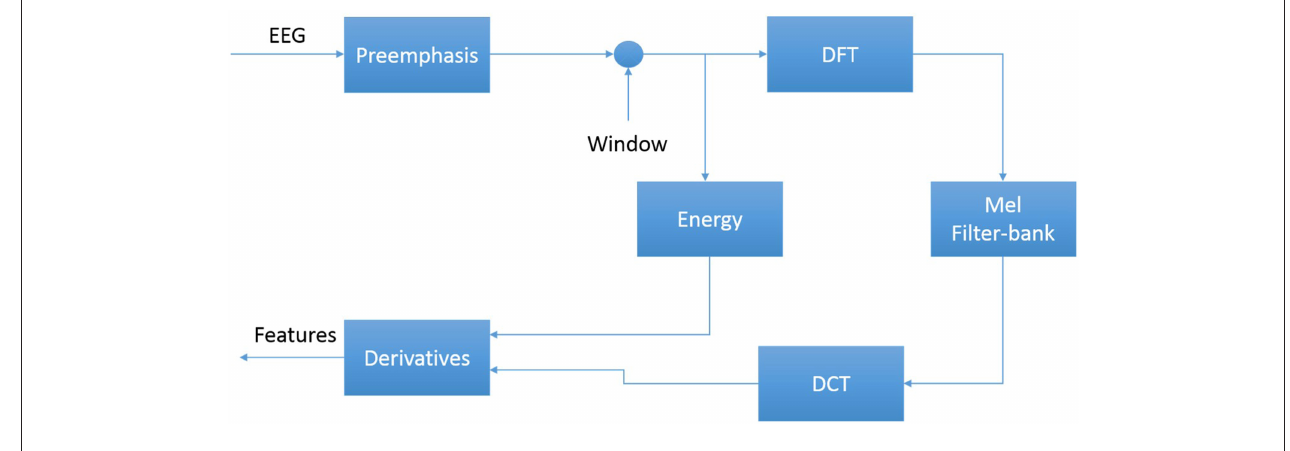
FIGURE 4 | An overview of the feature extraction algorithm.